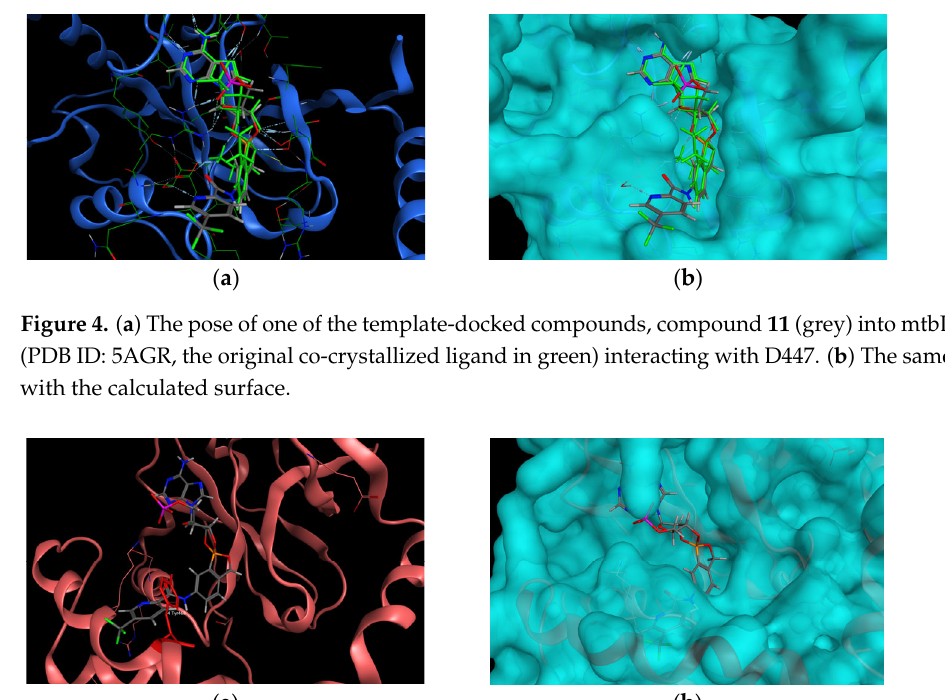
Figure 5. Superimposition of the hLeuRS (PDB ID: 2WFD) visualized with docking results of compound 11 (grey color). ( a ) 2WFD hLeuRS (pink color) visualized without calculated surface with highlighted Y468 (red color). ( b ) 2WFD hLeuRS visualized with the calculated surface.